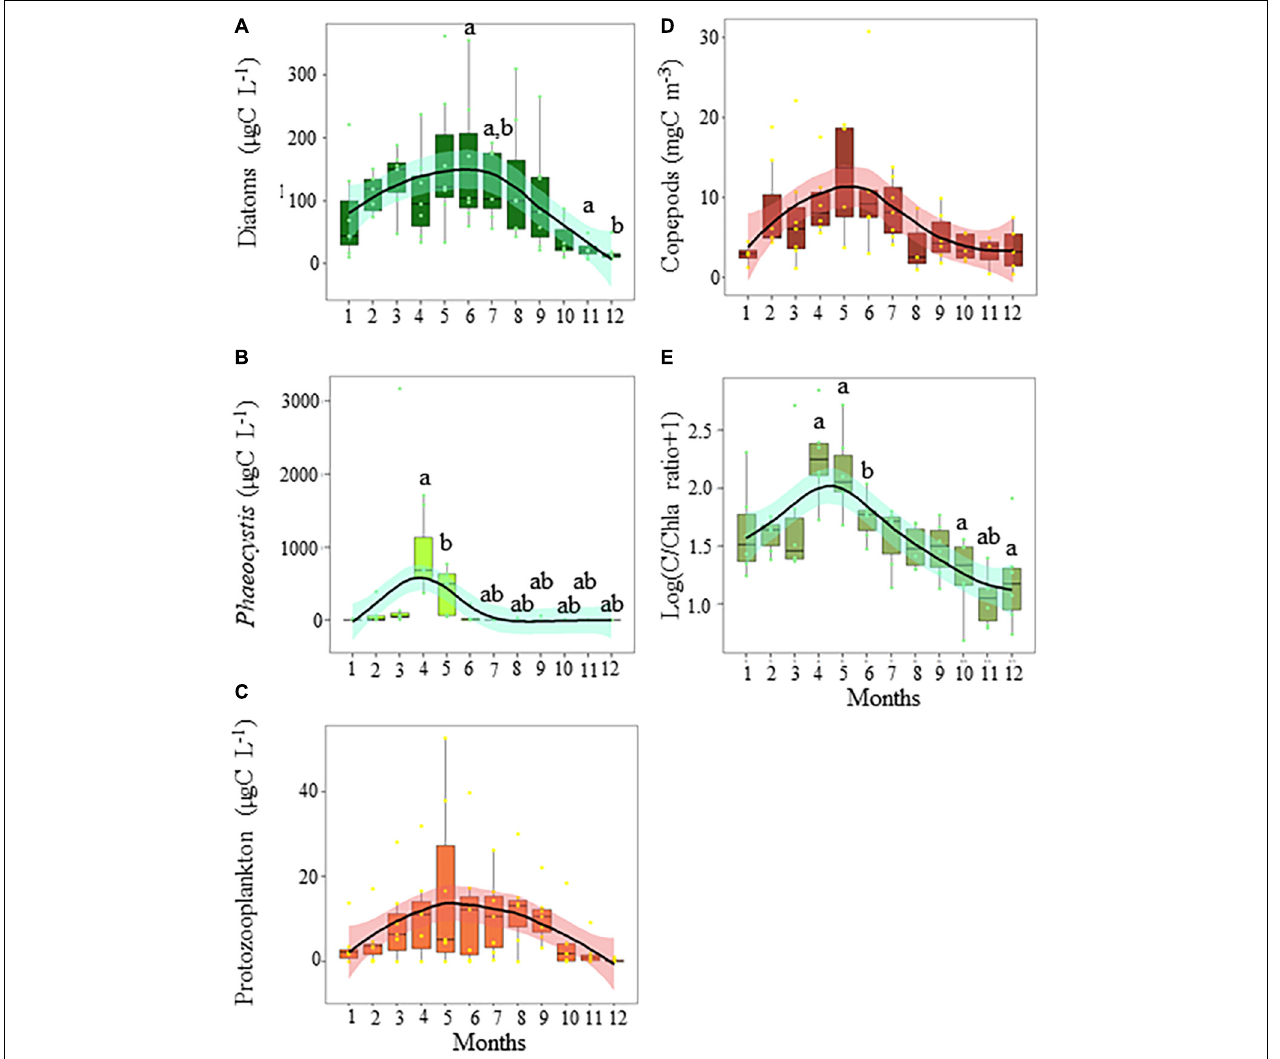
FIGURE 3 | Seasonal variations in the biomass (mgC L − 1 ) of panel (A) diatoms, (B) Phaeocystis , (C) protozooplankton (ciliates and dinoflagellates), (D) copepods (mgC m − 3 ), and (E) the C/Chla ratio in coastal waters of the eastern English Channel over the period 2007–2013. Black horizontal line inside box: median; box: first to third quartiles; whiskers: 1.5 times the interquartile range (IQR); dots: monthly data including outliers ( > 1.5 times IQR). The labels a and b show significant differences between months ( p = 0.05, Nemenyi test). The solid line and ribbon represent LOESS smoothing and the 95% confidence interval, respectively.